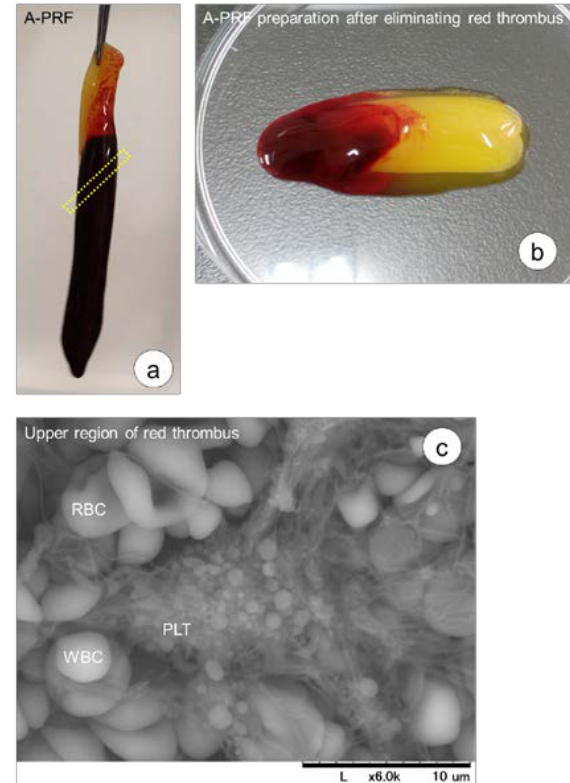
5 of 11 Figure 3. WBC ( a,c ) and platelet (PLT) counts ( b,d ) in the A-PRF ( a,b ) and CGF preparations ( c,d ). Peripheral blood samples were collected into glass tubes in the absence of the anti-coagulant and centrifuged by the individual centrifugation protocols. The freshly formed fibrin clots were withdrawn and dissected from the RBC clots. The resulting A-PRF/CGF preparations were compressed to collect the exudate fractions, whereas the RBC clots were minced and gently combined with the liquid form of RBC fraction. WBC and platelet counts were determined in the whole samples,